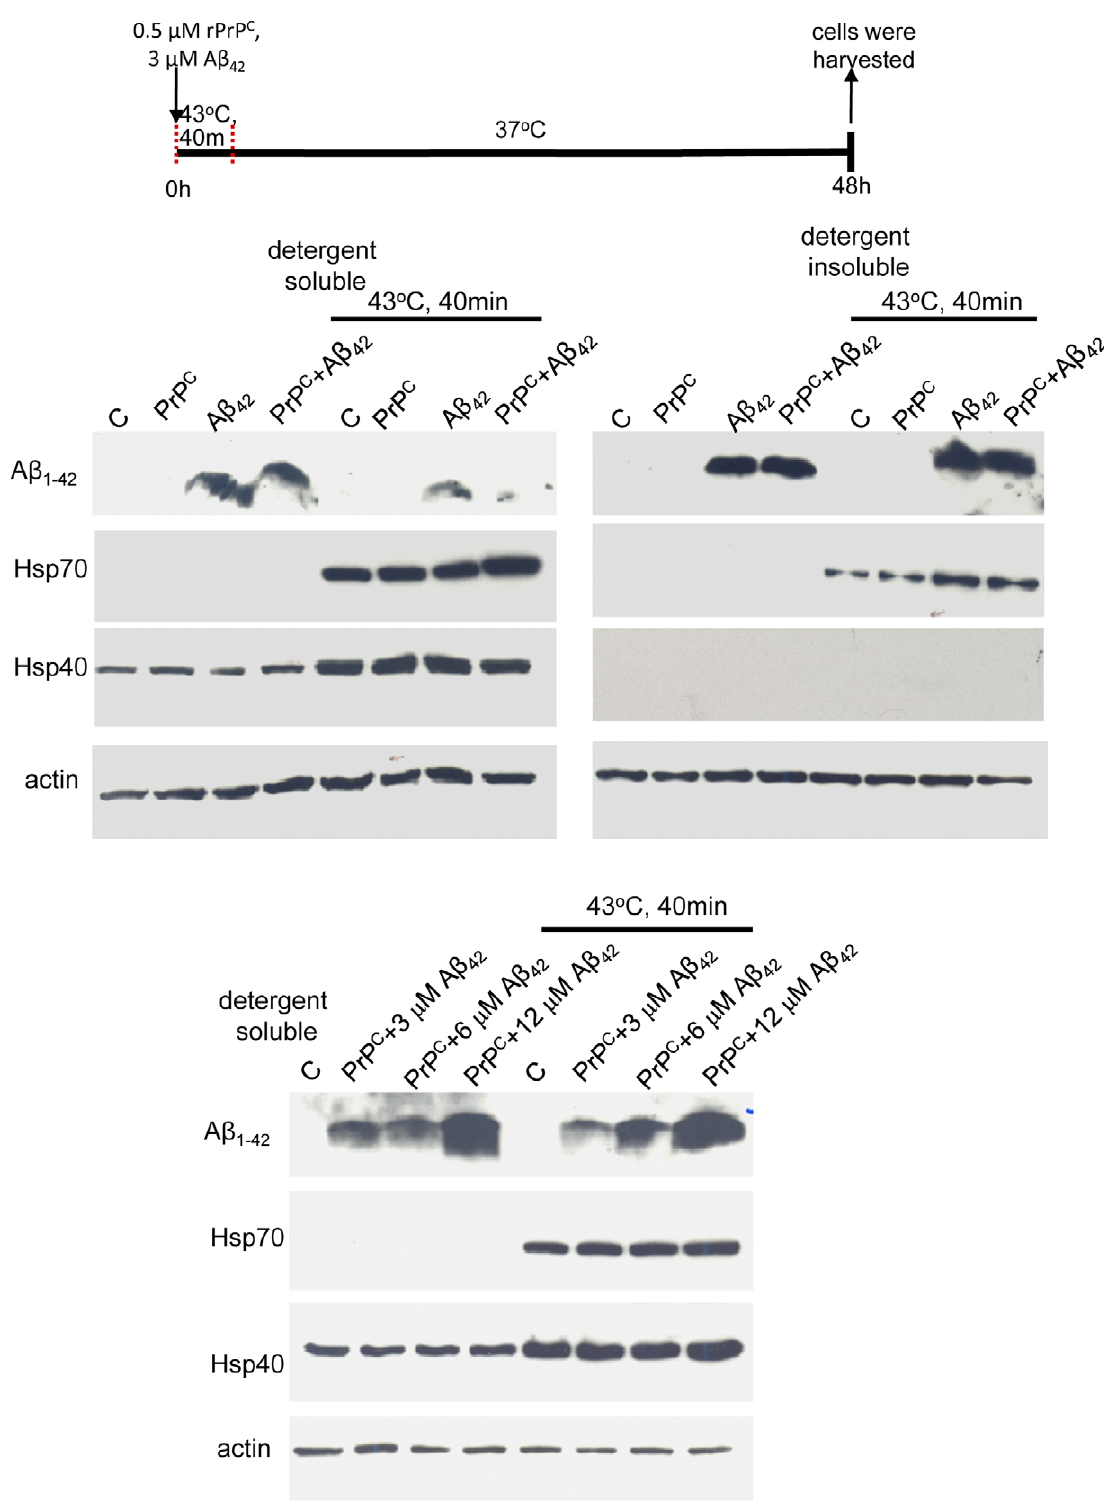
Figure 4. A b 42 levels are reduced 48 hours following induction of the cellular heat shock response. CAD cells were incubated with 3 m M A b 42 and/or 0.5 m M bovine rPrP C . Immediately following addition of A b 42 or rPrP C , the cells were subjected to heat-shock at 43 u C for 40 minutes, allowed to recover for 48 hours, and washed in PBS prior to lysis. 30 m g of soluble cellular protein or 10 m l of the insoluble fraction was resolved by SDS-PAGE and subjected to Western blot analysis. Lower panel: CAD cells were incubated with the indicated increasing concentrations of A b 42 and/or 0.5 m M mouse (L42) rPrP C . Data are representative of 3 separate experiments.